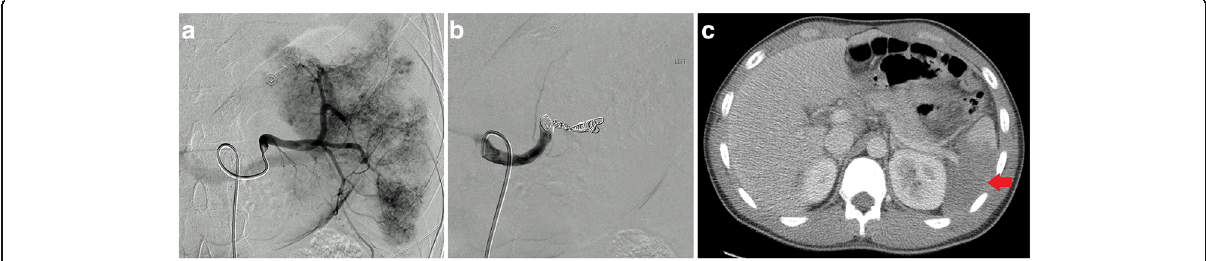
Fig. 1 Catheter angiography from the splenic artery showing high grade parenchymal injury a successfully treated with proximal embolization b and patient with infarct after proximal embolization (arrow)